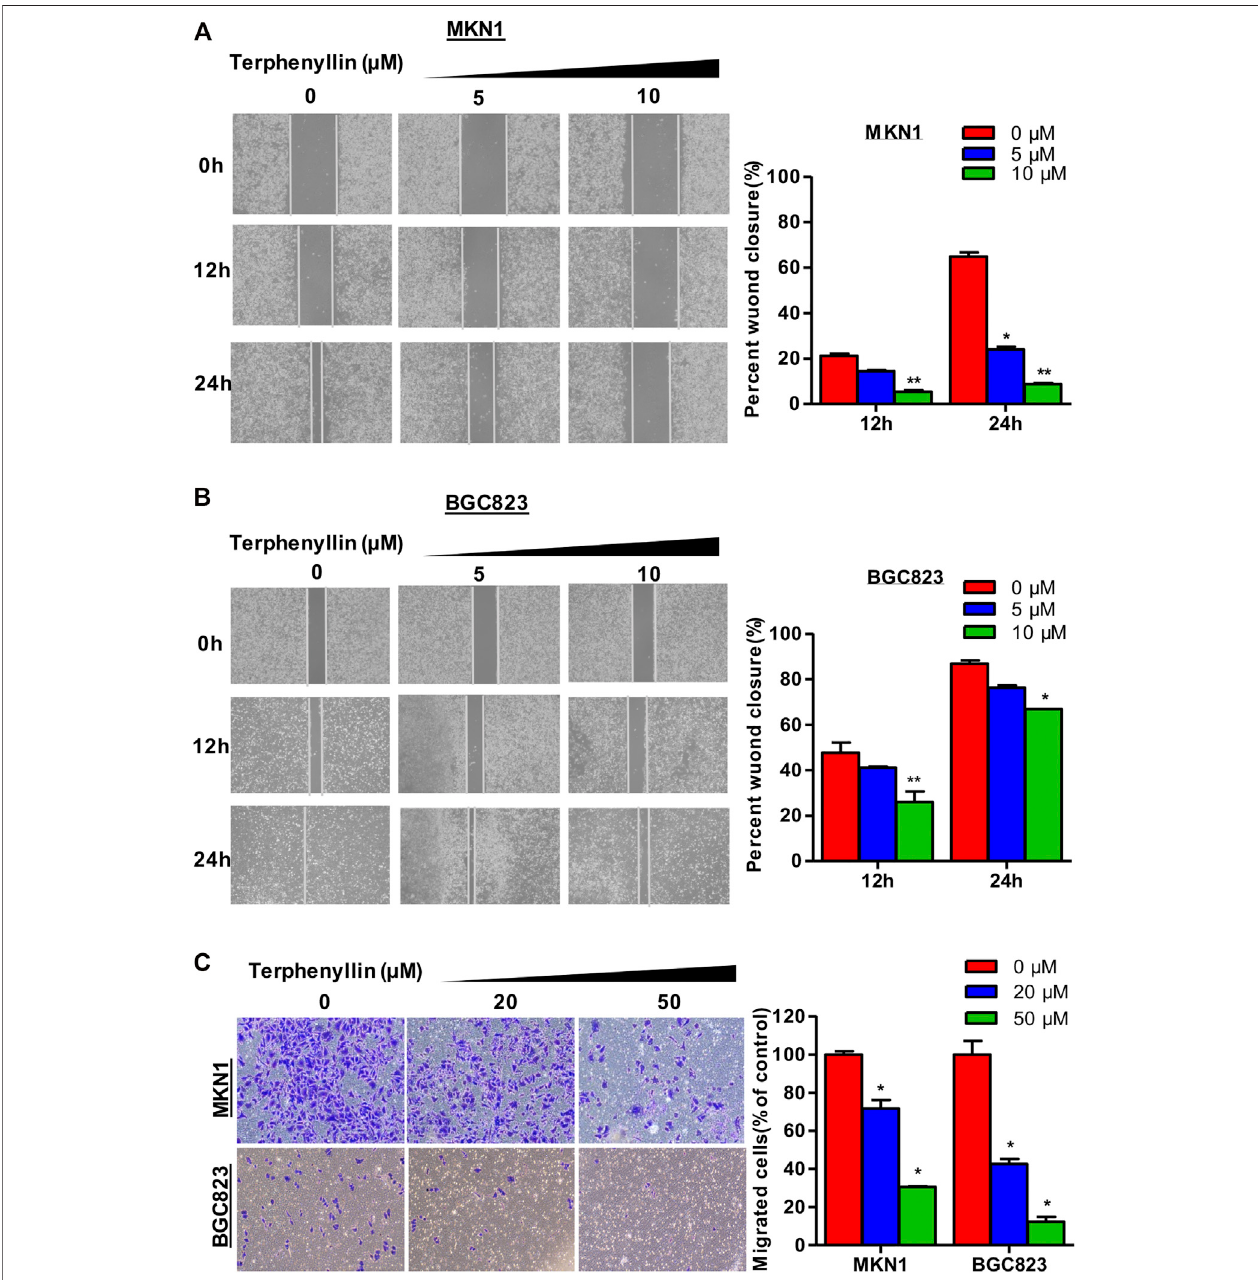
FIGURE 4 | Terphenyllin prevented the invasion and metastasis of gastric cancer cells in vitro . (A,B) In the wound-healing assay, MKN1 and BGC823 cells were treated with terphenyllin at the speci fi ed concentration for 24 h, and the degree of cell healing was observed and recorded every 12 h. (C) Transwell invasion assay was carried out in MKN1 and BGC823 cells treated with or without terphenyllin. Results are presented as mean ± SD. ( p p < 0.05; pp p < 0.01, ppp p < 0.001).